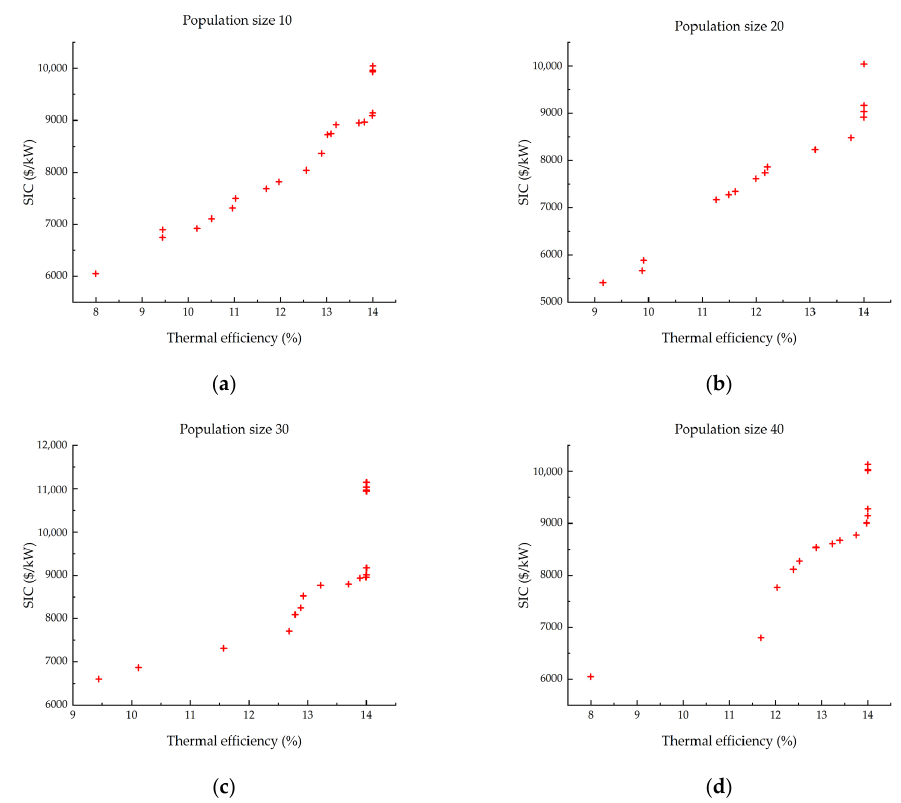
Figure 7. The effect of population size on the optimization results: ( a – d ) Population sizes were 10, 20, 30, and 40, respectively.